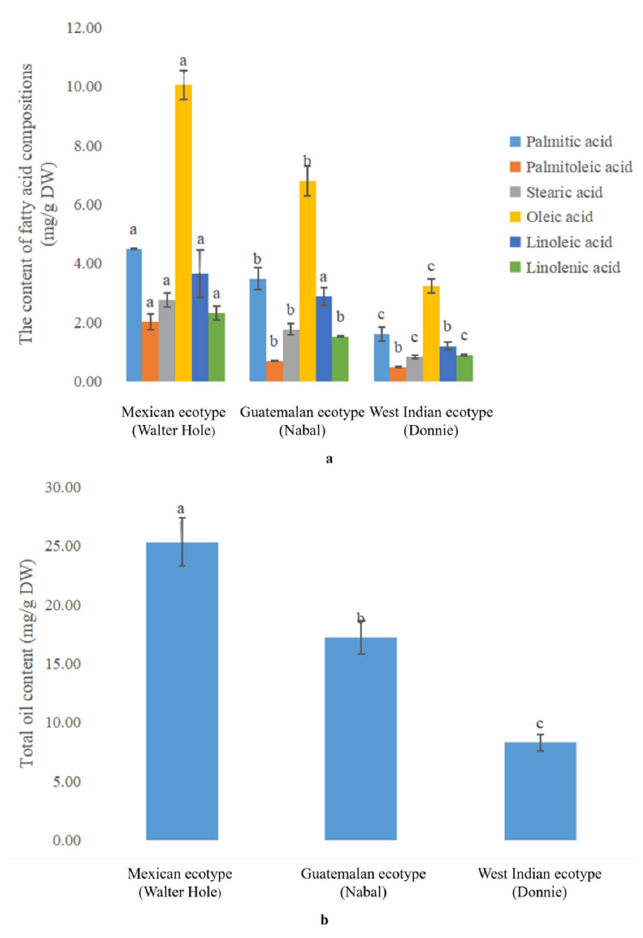
Figure 2. Total oil contents and fatty acid compositions of the mature avocado mesocarps of three ecotypes. ( a ) Fatty acid compositions in the mature avocado mesocarps; ( b ) Total oil contents in the mature avocado mesocarps. Error bars indicate standard deviation from three biological replicates with two technical replicates of each. Means with different letters in the same color histogram indicate significant differences (Duncan, p ≤ 0.05).